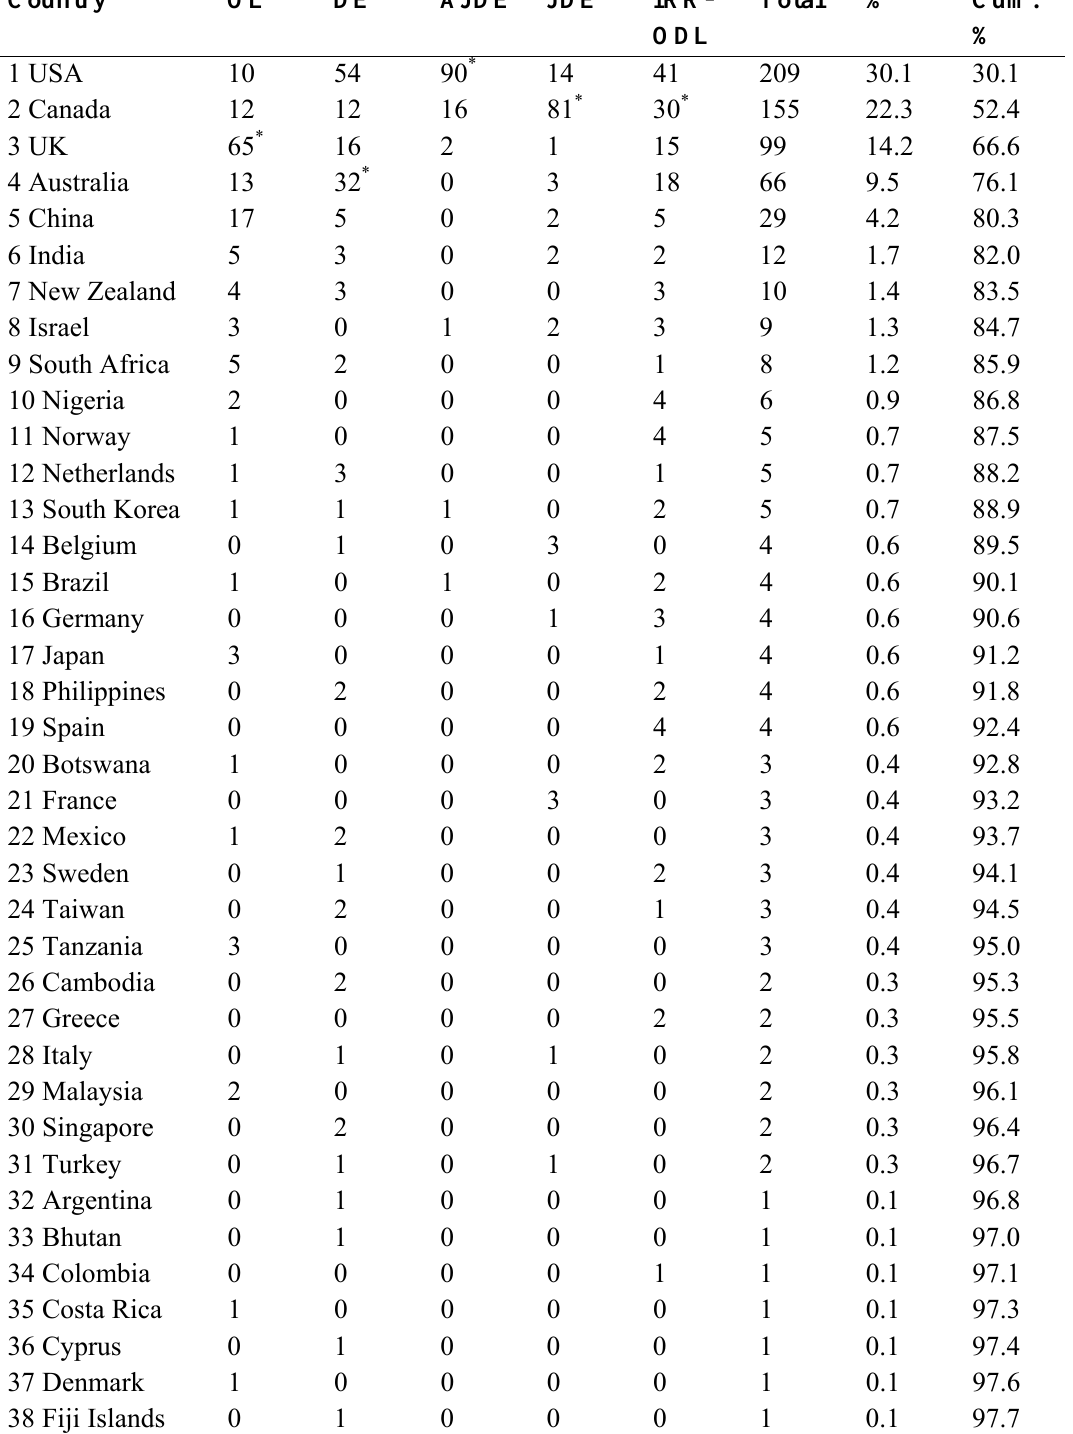
Table 11 Cross Tabulation of Countries (First Author) and Journals